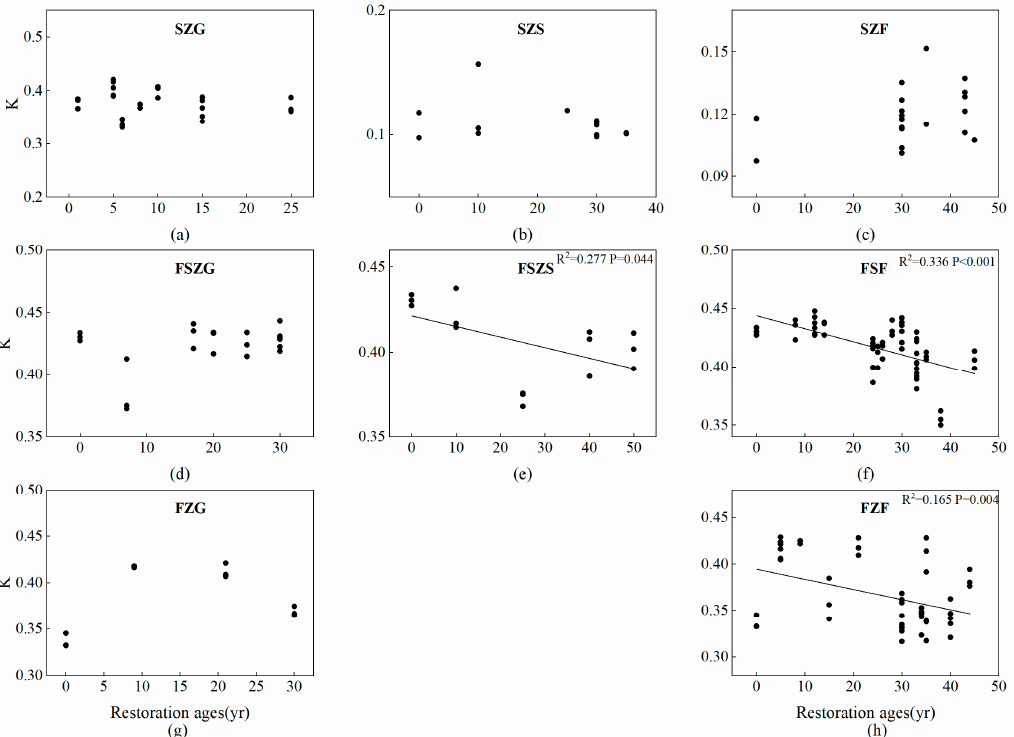
Figure 5. Changes to the erodibility factor of the vegetation zones across the vegetation restoration chronosequence. ( a – c ) show changes to the K factor of SZG, SZS, and SZF with restoration age, respectively; ( d – f ) show changes to the K factor of FSZG, FSZS, and FSZF with restoration age, respectively; ( g – h ) show changes to the K factor of grassland and forests varied restoration age in the forest zone, respectively.